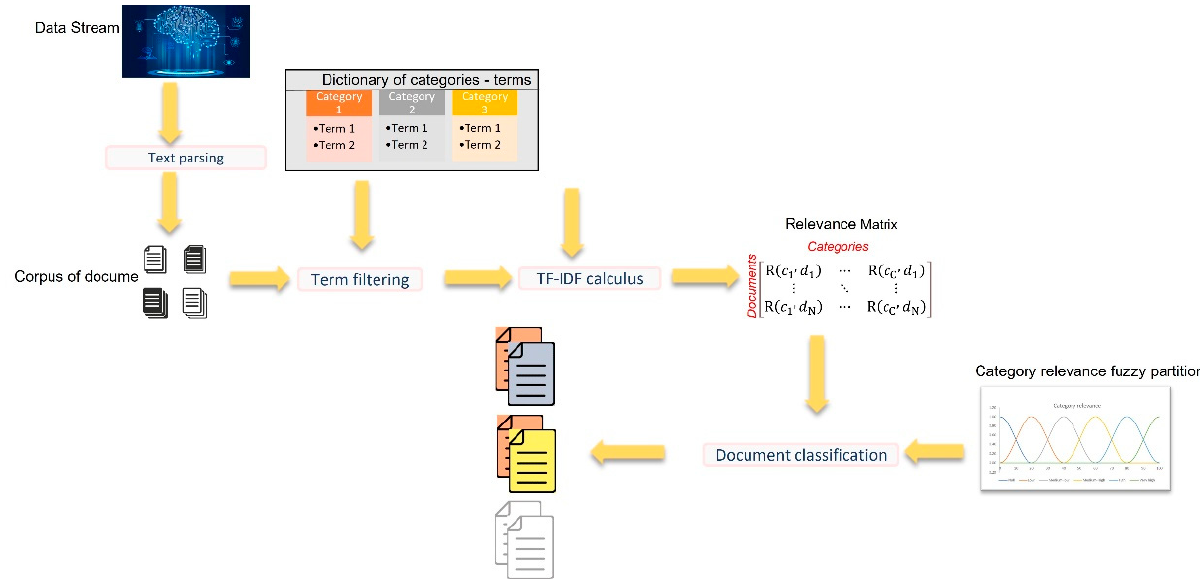
Figure 1. Schema of FREDoC. Initially, the user produces a dictionary of categories—terms , in which all terms falling into a category are collected and assigned to that